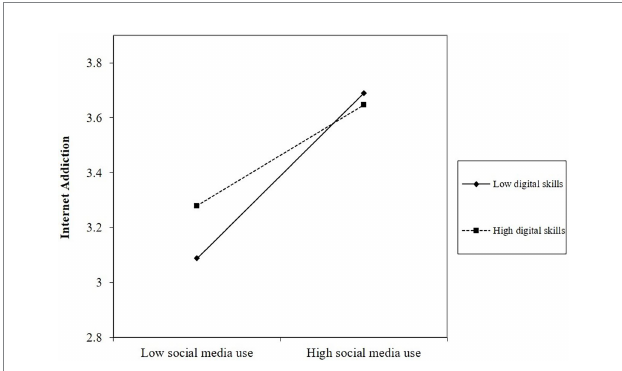
FIGURE 2 The moderation effect of digital skills on the relationship between SMU and Internet addiction.